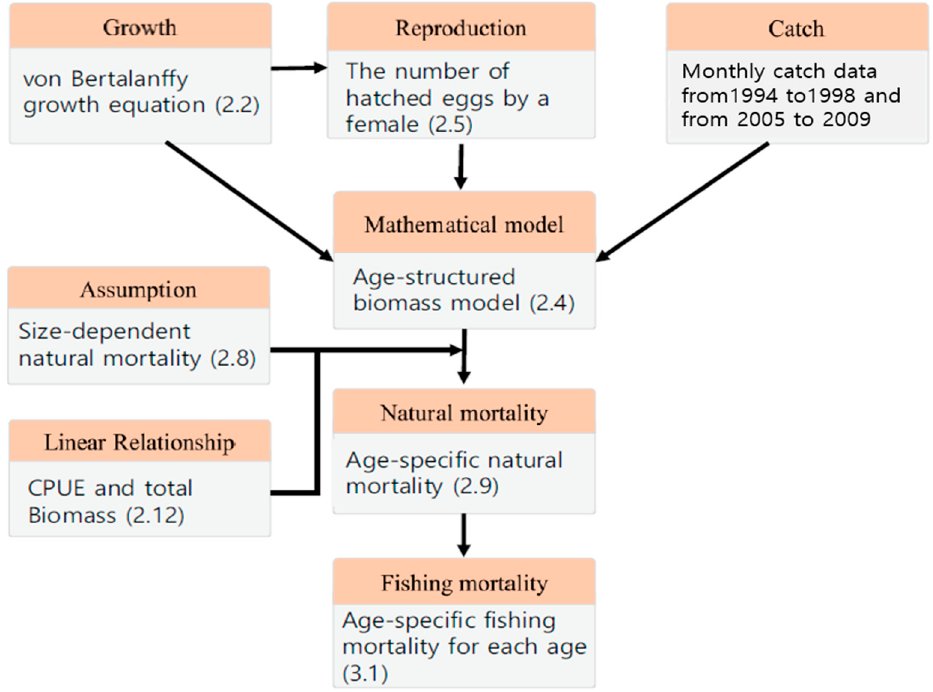
Figure 1. Schematic flowchart summarizing the methods used to estimate natural morality of sandfish in the eastern coastal waters of Korea. The number in parentheses indicates the equation number related to the description in the paper.